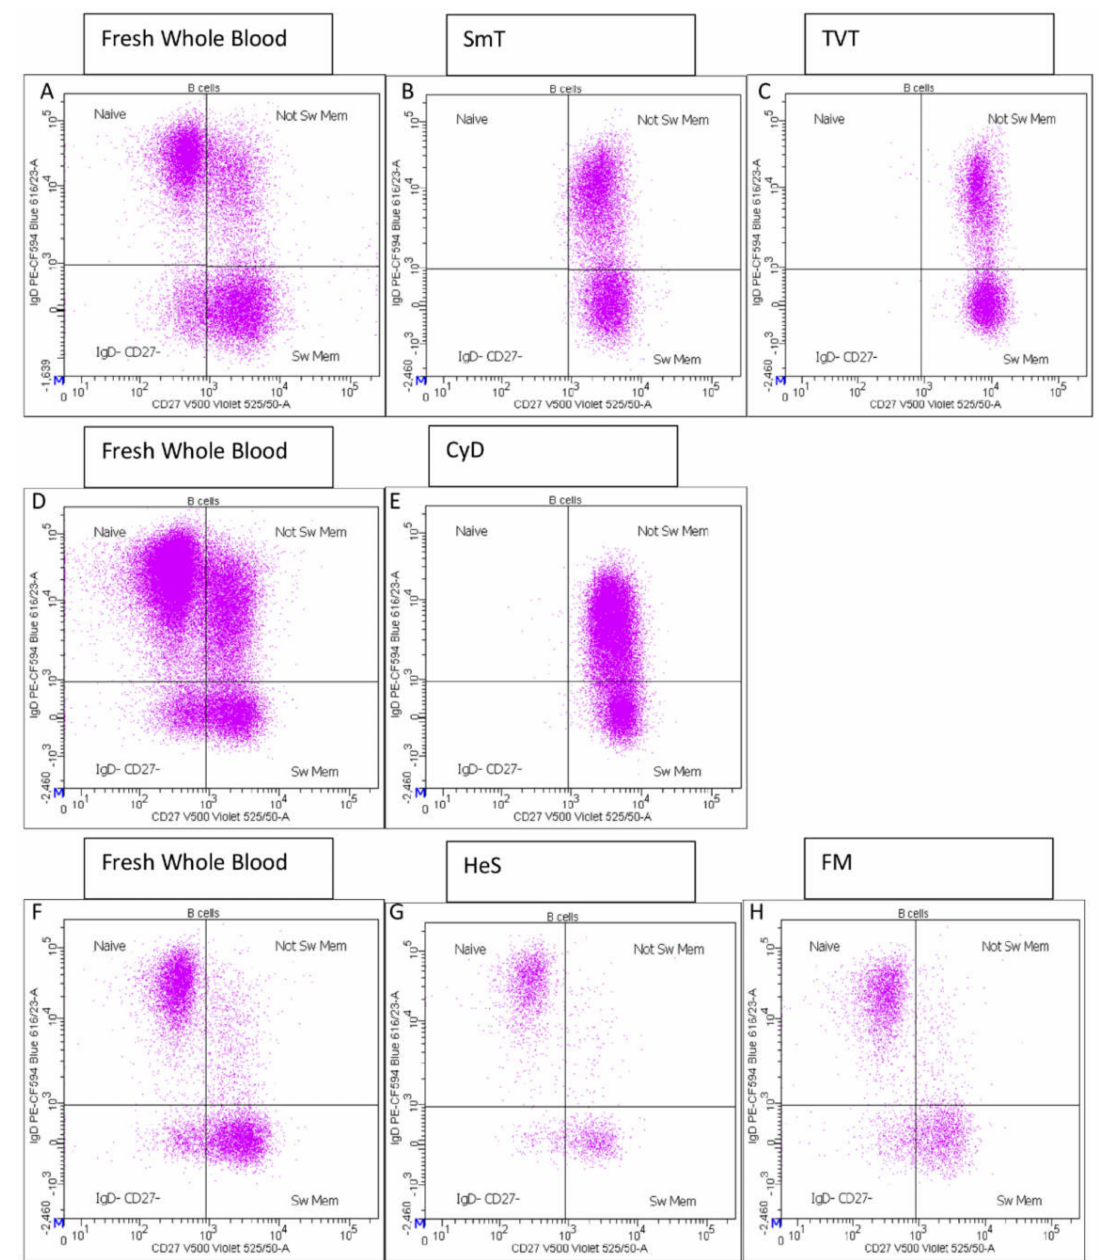
Figure 4. Representative CD27 staining of fresh whole blood and thawed samples. The corresponding fresh whole blood is shown on the same line for each freezing method: fresh blood ( A ) is the control for SmT ( B ), and TVT ( C ) methods; fresh sample ( D ) is used as the control for CyD ( E ) method, and fresh sample ( F ) for HeS ( G ) and FM ( H )